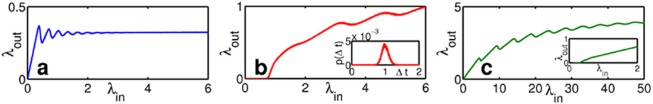
Non-monotonicity of response curves is robust against irregularity of the input.Panels (a)–(c) show the input-output response of the LIF model system receiving input spike sequences with Gamma-distributed inter-spike intervals. The system parameters in (a) and (b) are identical to the system parameters in Fig. 2(a),(b). (c) shows the response of the system for parameters τ = 4, μ = 1, u = 0.2, c = 0.5 and Veq = 0, where the inset demonstrates that for small input rates no output is generated. Inset of (b) shows the distribution for one fixed input rate, normalized to one. The shape parameter of the distribution was set to α = 100, so that the relative standard deviation of the input intervals is σΔt/Δt¯=0.1.